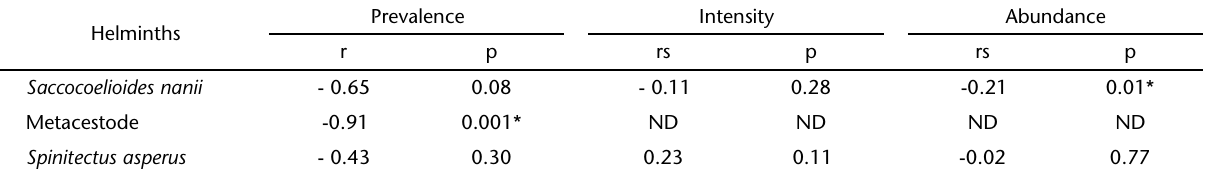
Table IV. Analysis of the influence of total length of P. argenteus from the Upper São Francisco River, Minas Gerais, on the parasitic prevalence (r), intensity (rs) and abundance (rs). (r) Pearson correlation, (rs) Spearman's rank correlation coefficient.